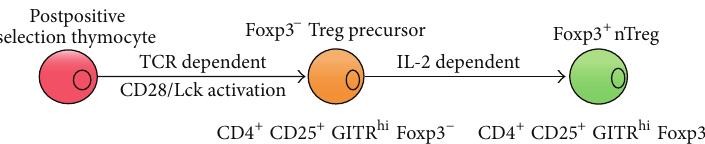
Figure 1: The stages of tTreg development. Thymic Treg development is achieved in two stages. Initially, postpositive selected thymocytes undergo TCR and CD28 dependent maturation into a Foxp 3 − tTreg precursor population. A subsequent IL-2 dependent step leads to the development of Foxp3 expressing mature